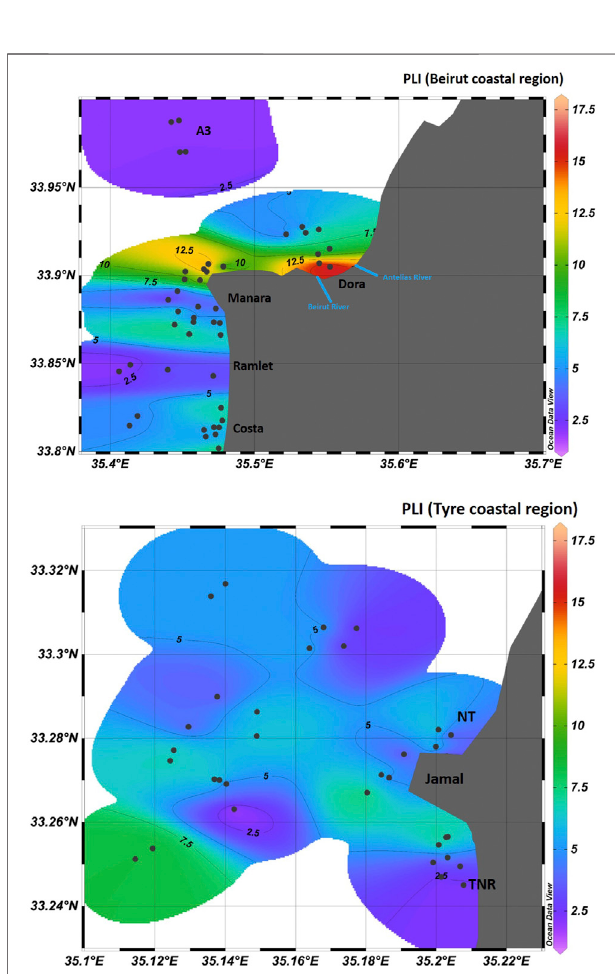
FIGURE 11 | Pollution Load Index (PLI) of MPs in the coastal marine areas region of Beirut (top) and Tyre (bottom) .